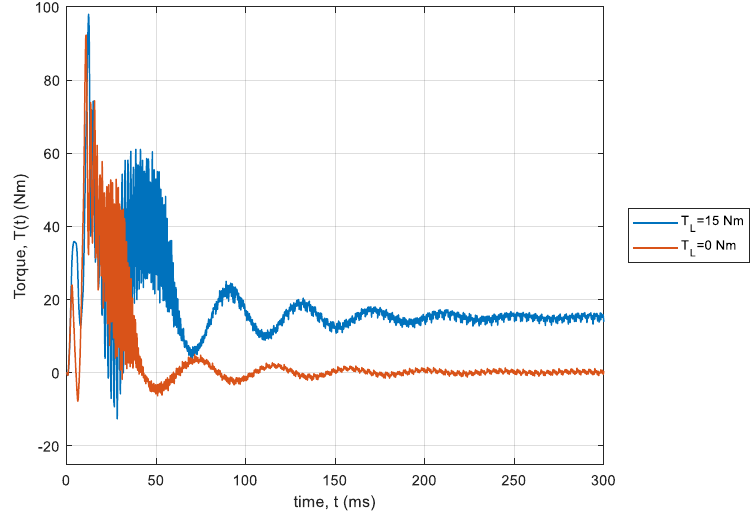
Figure 4. Torque waveforms of a healthy motor at T L = 0 Nm and T L = 15 Nm.